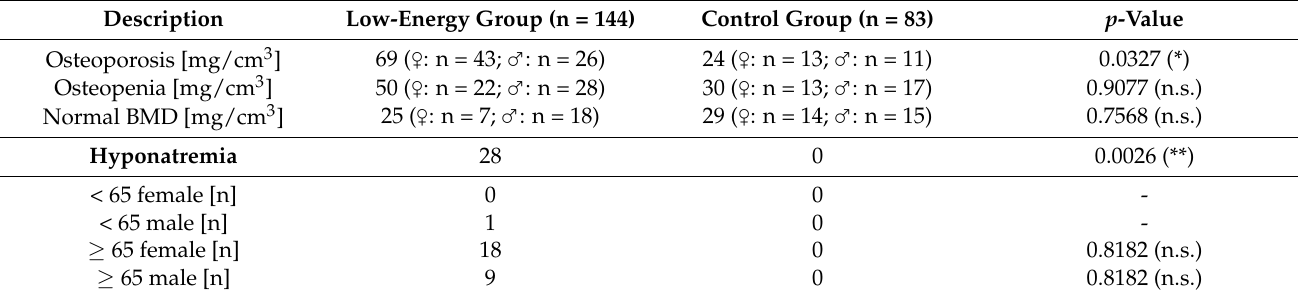
Table 3. QCT Spinal Bone Mineral Density Classification of the American College of Radiology.